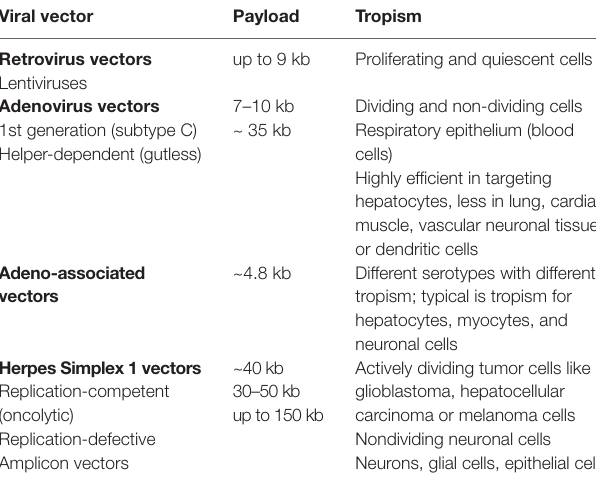
TABLE 1 | Main features of the most commonly employed viral vectors for CNS gene